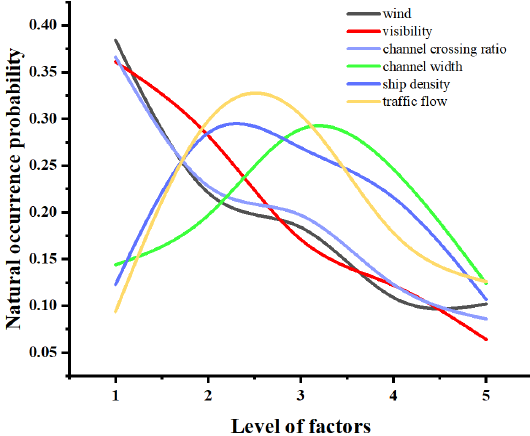
Figure 4. Probability of the natural occurrence variation in navigational environment impact factors at different levels.